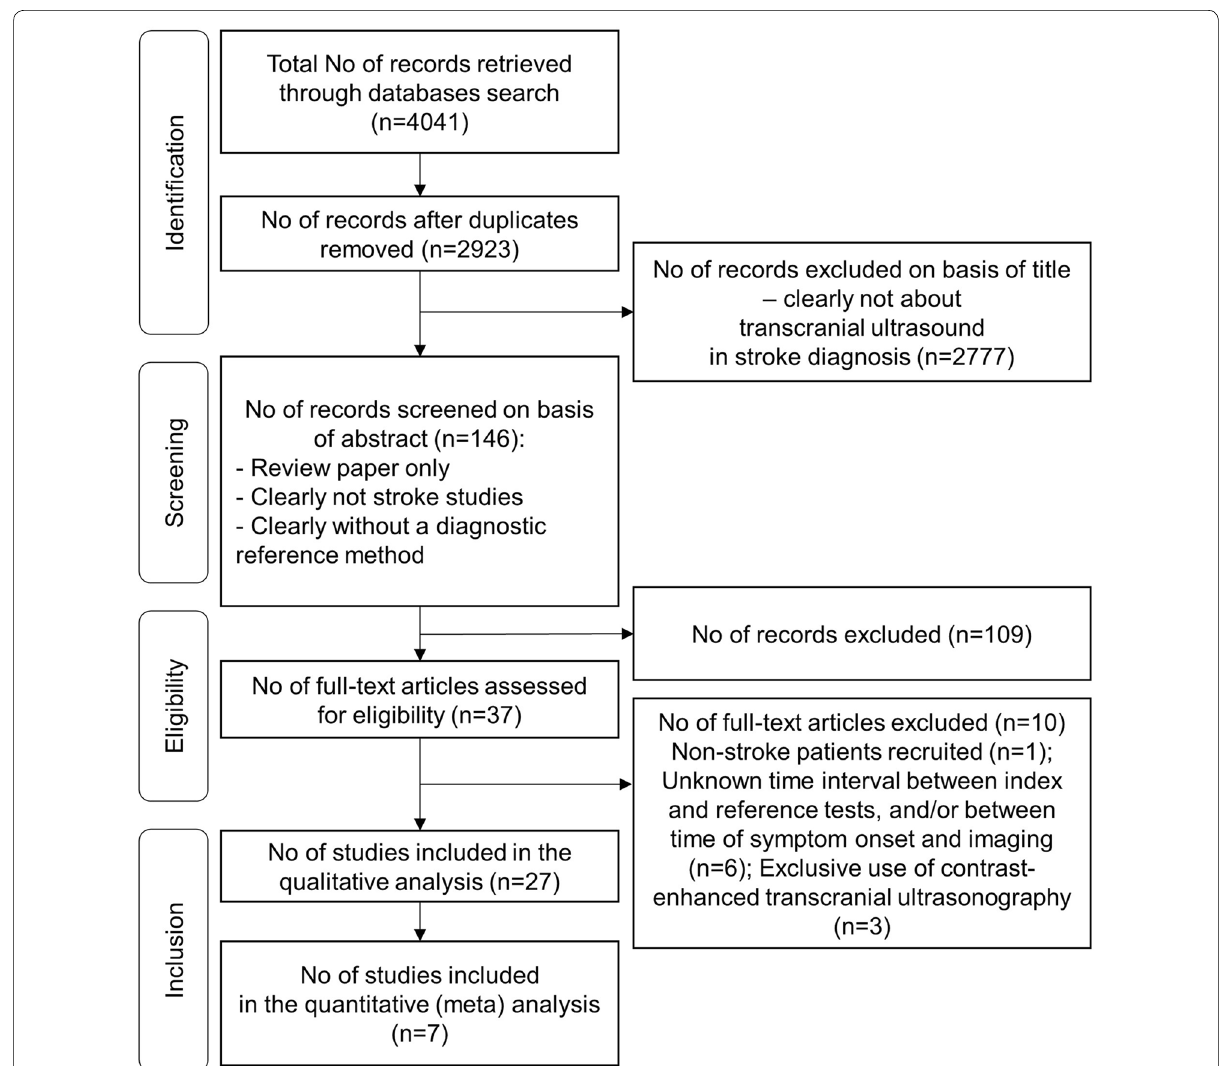
Fig. 1 PRISMA flowchart. Outline of the study selection process using inclusion and exclusion